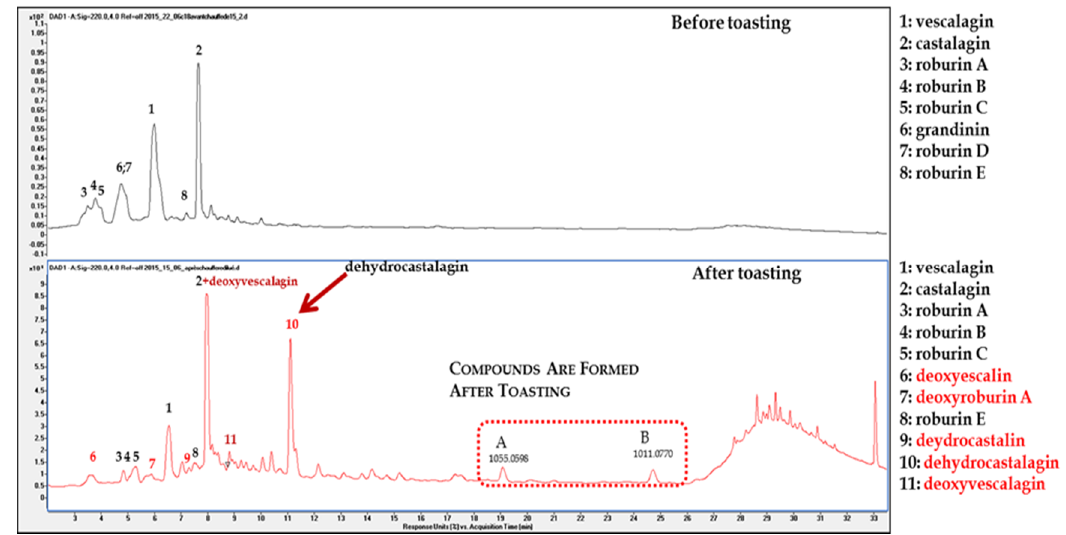
Figure 2. Comparative UV chromatogram before and after toasting.